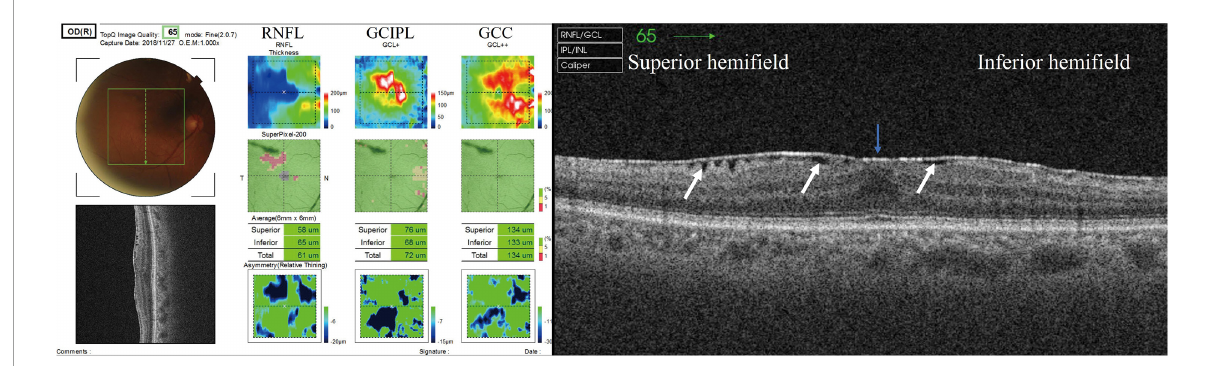
FIGURE1 GCC mapping (RNFL, GCIPL, and GCC) and radial scan. (Left panel) GCC thickness map obtained using SS-OCT. RNFL thickness + GCIPL thickness = GCC thickness. (Right panel) White arrow showing SUKIMA. Severity of ERM was grade 2 and SUKIMA was observed in both superior and inferior